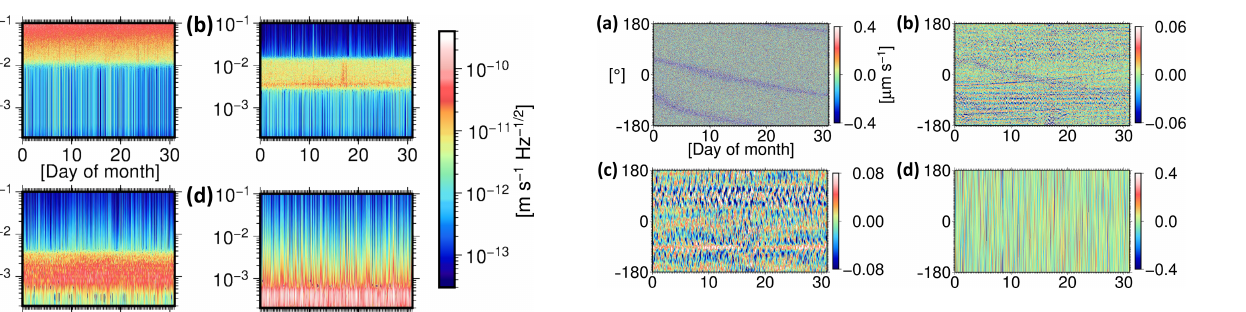
Figure 8. Orbital analysis of (a) short timescale, (b) medium timescale, (c) long timescale, and (d) approximation components of the residual signal. The values are plotted with respect to the GRACE-A argument of latitude for December 2008.